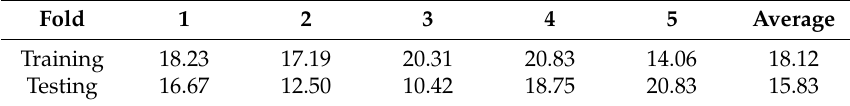
Table 3. Error rate (%) of five-fold cross validation.